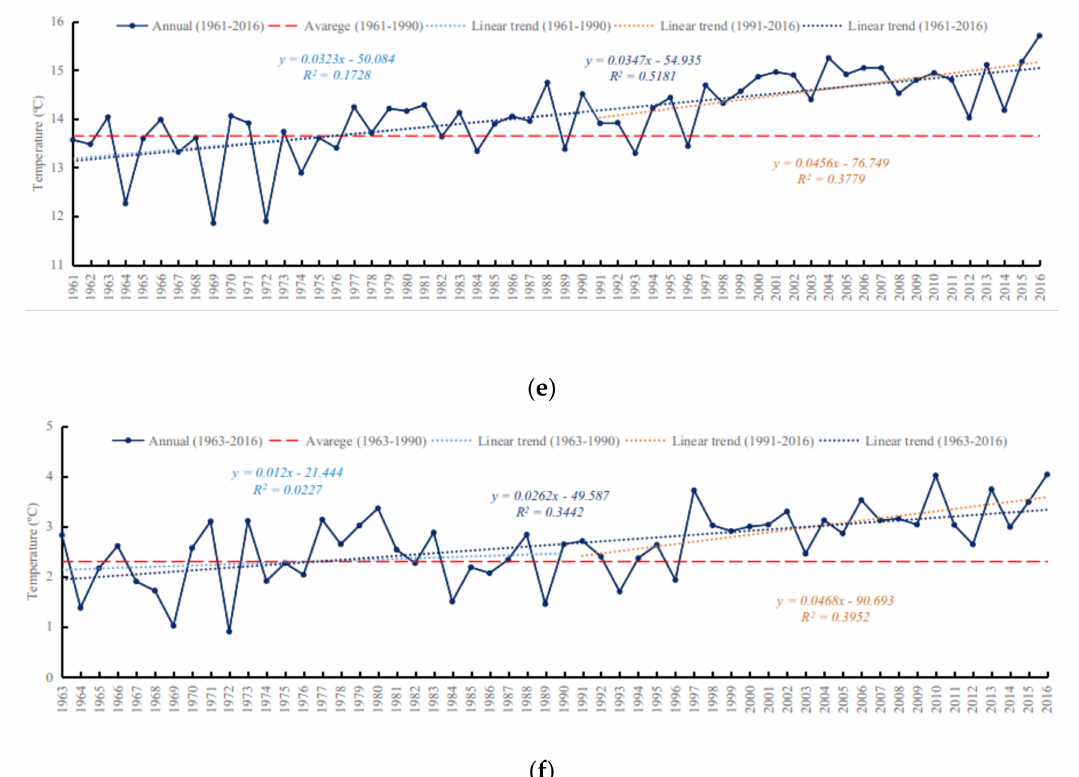
Climate 2020 , 8 , x FOR PEER REVIEW 11 of 23 Figure5. Interannualtemperaturechangeatthedesert( a , b ), oasis( c – e ), andmountain( f )meteorological temperature trend, while Termez station, the most southern part of Uzbekistan, remained stations. ( a ) Karakalpakia; ( b ) Tamdi; ( c ) Tashkent; ( d ) Termez, ( e ) Ferghana, ( f ) Oygaing. unchanged.